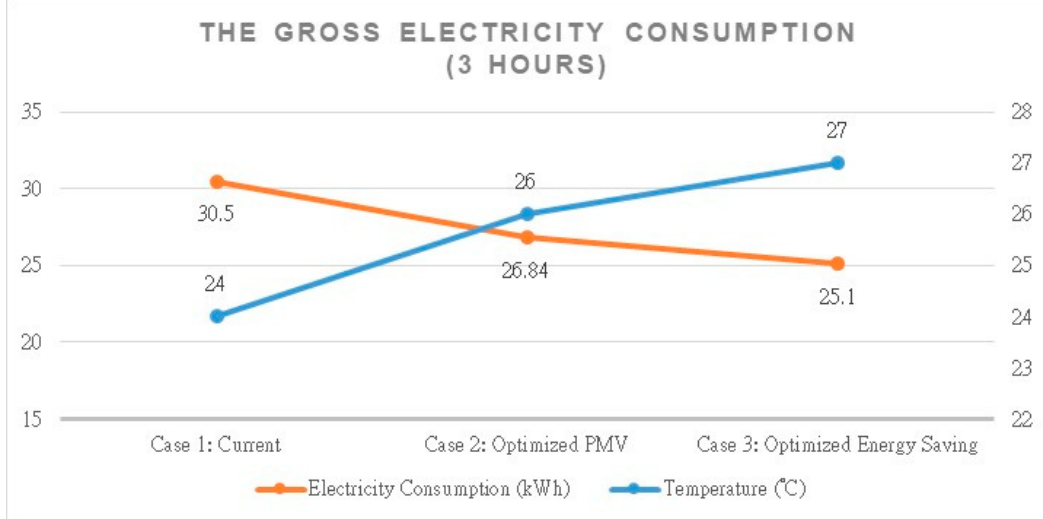
Figure 11. The different settings’ analysis and comparison for energy conservation. Figure 11. The di ff erent settings’ analysis and comparison for energy